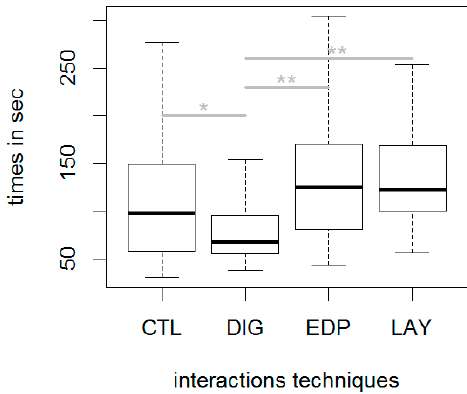
Figure 9. Response times for the Relate task per interaction technique. DIG is the quickest interaction technique to estimate distance relationships between elements. (* P < 0.05, ** P < 0.01).